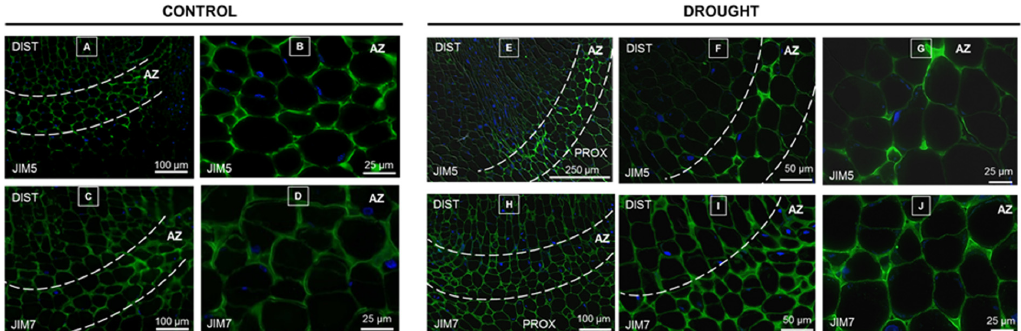
Figure 4. Drought leads to redistribution of low- and high-methylated pectin in the abscission zone (AZ) area. Immunolocalization of pectin in the flower AZ of yellow lupine cultivated under soil drought conditions (25% WHC, water deficit conditions) ( E – J ) and AZ of control lupines growing in the soil of optimal moisture (70% WHC) ( A – D ). For analysis, sections of AZs (marked by the white dotted line) were collected on the 48th day of cultivation. Low-methylated and un-methylated homogalacturonans (HGs) were detected by JIM5-Ab, while JIM7-Ab was used to localize high-methylated HGs. Green fluorescence indicates the pectin presence, while the blue signal corresponds to nuclei stained with DAPI. Images ( B ) and ( D ) are magnifications of AZ areas presented in ( A ) and ( C ) , respectively. Images ( F ) and ( G ) are magnified regions presented in ( E ). Images ( I ) and ( J ) are magnified regions presented in ( H ). Abbreviations: DIST—distal region, flower pedicel fragment above the AZ; PROX—proximal region, stem fragment below the AZ. Bars are given on each image.